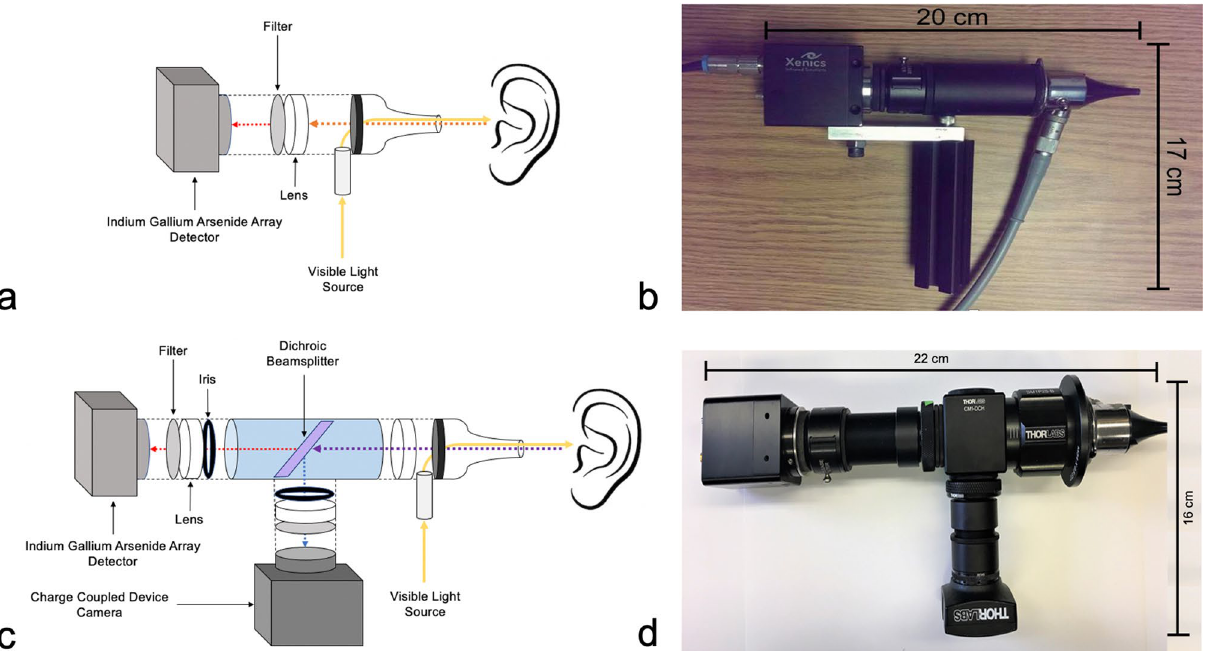
Figure 1. Prior and current iterations of the prototype shortwave infrared (SWIR) otoscope. ( a ) Schematic of the prior SWIR otoscope used by our group. Light is reflected off the tympanic membrane into a lens, then through a 1300 nm long pass filter into a SWIR light detector array, ( b ) image of prior prototype otoscope, ( c ) schematic of current prototype SWIR otoscope, featuring simultaneous visible light and SWIR capturing due to incorporation of a dichroic beam-splitter, finer tuning of exposure with adjustable iris diaphragms, and improved ergonomics, ( d ) image of current prototype Automatic segmentation and parameterization followed to produce a binary mask of each frame and identify input features. A de novo deep learning model was devised to make predictions based on these input features, using simple thresholding and Random Forest techniques for classification. Preprocessing and segmentation involved manual review of the SWIR otoscopy images. Each 60 s video was reviewed in a blinded fashion by an otolaryngologist frame by frame. First, the most representative single frame of the tympanic membrane was identified. This was termed “best frame”. Second, an image sequence consisting of 20–22 consecutive frames was randomly selected within each video, termed “frame range”. Third, for each “best frame” and “frame range”, the region of interest (ROI) within each frame was identified. This was performed by excluding regions of artifact such as cerumen, hair, or out of focus regions, leaving only the focused representa- tive portions of the tympanic membrane. A total of 1179 frames were manually annotated. Figure 2 provides an illustration of the ROI and annotations performed. Several approaches to automatic segmentation were tested. These included circle selections using Hough transform static thresholding, adaptive thresholding, K-means segmentation, active contours, and blurred parts detection. However, these methodologies were only able to find pixels outside the ROI, meaning they were highly specific but lacked adequate sensitivity. Therefore, we tested deep-learning-based semantic segmentation to enhance the predictive power of the program. This method can take red–green–blue (RGB) or grey images as input and produce segmented fields of individual classes as output. An example of an input for a single frame, and the output (binary mask after segmentation) is presented in Fig. 3. There were only two output classes—(1) belonging to the ROI and (2) not belonging to the ROI. All operations were performed using MATLAB R2019A (Mathworks, Natick MA, https:// www. mathw orks. com/ produ cts/ matlab. html). The network was built using the segnetLayers() MATLAB function. without using pre-trained weights values, with an encoder depth of 3. Input image size was matched to 128 × 160. The training option selected was the stochastic gradient descent with momentum of 0.9. Data augmentation was implemented with ± 15 pixels in each direction. There were 60 epochs, 10,560 iterations, and 20% of all frames were chosen to be a validation subset. For all considered frames, the average intensity measure (Input Set 1) inside the region of interest was cal- culated. Also, other statistical intensity features were calculated, creating Input Set 2. All were treated as global measurements based on the entire region of interest rather than subsections. Apart from average intensity, we included median intensity, mean and median intensities of points being inside the interquartile range (IQR), mean and median intensities of points being greater (or less) than median intensity, and difference in intensities (maximum to median, median to minimum, and IQR). Next, we performed a standard machine-learning scheme (Fig. 4) to create and validate models. We established tenfold hold-out cross-validation with 62/38% division for training and testing subsets, respectively, and ensured the same distribution of two output classes in both subsets.